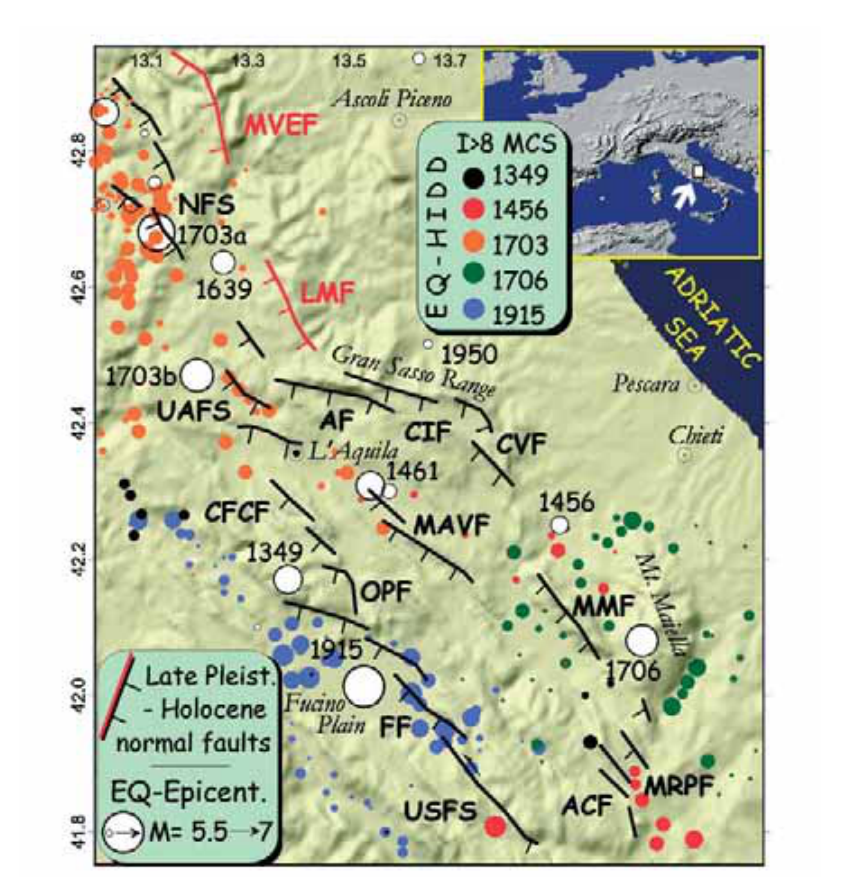
Fig. 1. Seismotectonic framework of the investigated area. The investigated faults are reported in red. Earthquake epicenters and the highest intensity datapoints distribution (HIDD; size proportional to intensity, I > 8 MCS) were taken from Magri and Molin (1984) for the 1456 earthquake, Boschi et al. (1995) for the 1349 and 1706 earthquakes, Monachesi and Stucchi (1998) for the 1703 earthquake, Molin et al. (1999) for the 1915 earthquake; all the epicen- ter locations were derived from Working Group CPTI (1999). MVEF - Mt. Vettore Fault; NFS - Norcia Fault System; LMF - Laga Mts. Fault; UAFS - Upper Aterno Valley Fault System; AF - Assergi Fault; CIF - Campo Imperatore Fault; CVF - Mt. Cappucciata-Mt. San Vito Fault; CFCF - Campo Felice-Colle Cerasitto Fault; MAVF - Middle Aterno Valley Fault; OPF - Ovindoli-Pezza Fault; MMF - Mt. Morrone Fault; FF - Fucino Fault; MRPF - Mt. Rotella- Mt. Pizzalto Fault; ACF - Aremogna-Cinquemiglia Fault; USFS - Upper Sangro Valley Fault